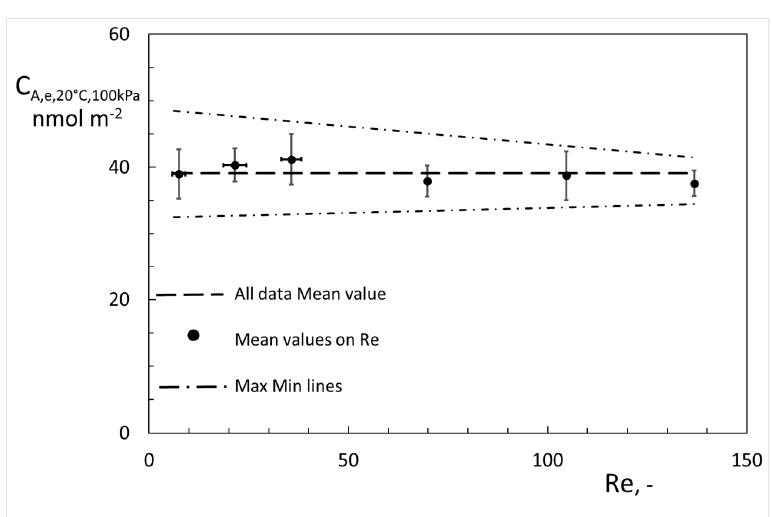
Figure 6. Sensitivity of adsorbed amount per unit area on Reynolds number. Values corrected at 20 °C, 1bar, and grouped on Re.